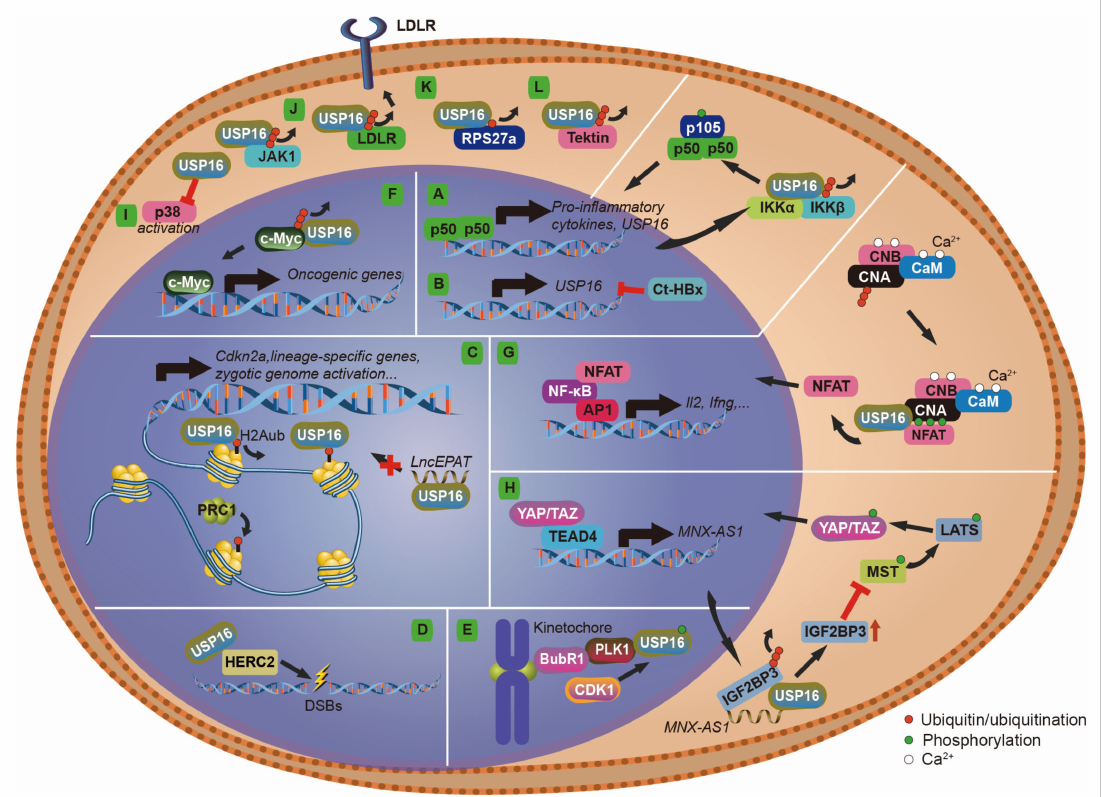
Figure 4. Substrates and functions of USP16 in the cytoplasm and nucleus. ( A ) Transcription of USP16 is under the control of the NF- κ B pathway, a pathway also regulated by USP16. ( B ) Ct-HBx inhibits the expression level of USP16 in hepatocellular carcinoma. ( C ) USP16 functions as a major deubiquitinase of H2A, and lncEPAT binds to USP16 and blocks its recruitment to chromatin. ( D ) The C-terminal HECT domain of HERC2 interacts with the coiled-coil domain of USP16 and possibly recruits USP16 to DNA damage foci. ( E ) USP16 deubiquitinates PLK1 for mitotic chromosome alignment. BubR1 is